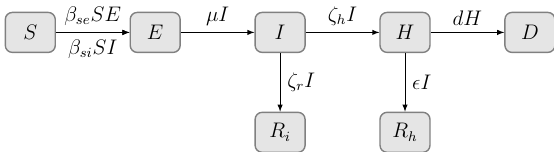
Figure 1. Transmission diagram for the COVID-19 model.